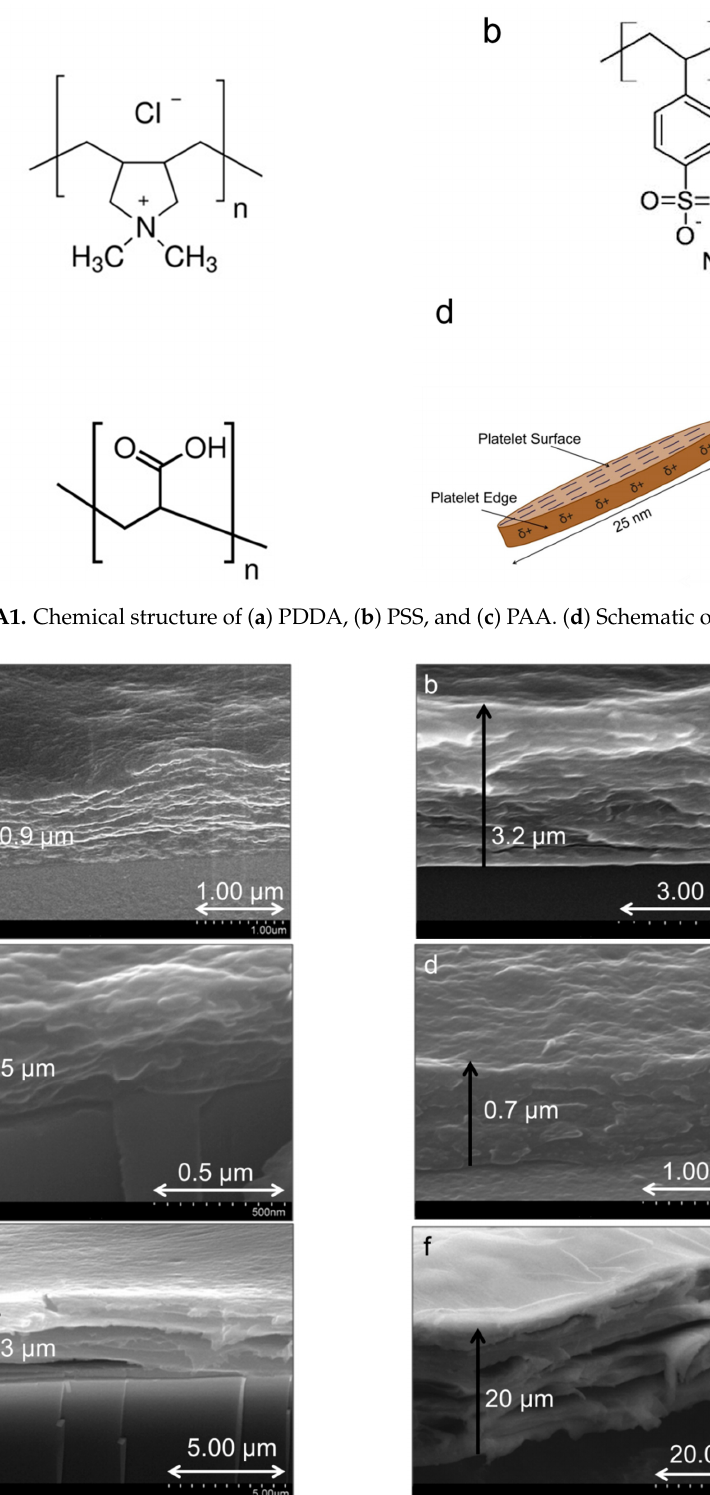
Figure A3. Photograph of a 180-layer PDDA-PAA-PDDA-Laponite free-standing film. (Size ~2 cm × 2 cm).